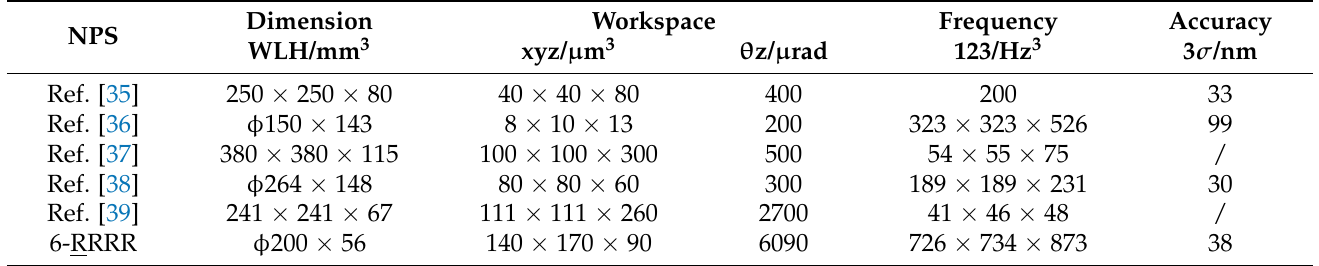
Table 11. Comparison of selected indexes of the mechanism design and mechanical